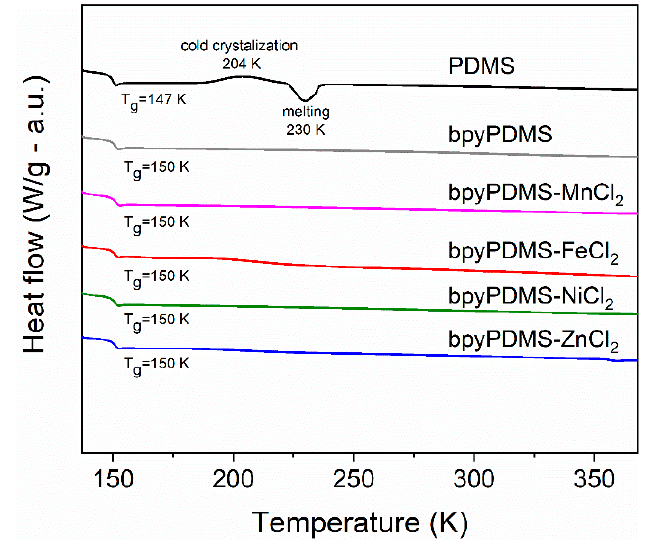
Figure 3. DSC thermograms of PDMS, bpyPDMS, and metalloorganic complexes (thermograms are vertically shifted for better visualization).